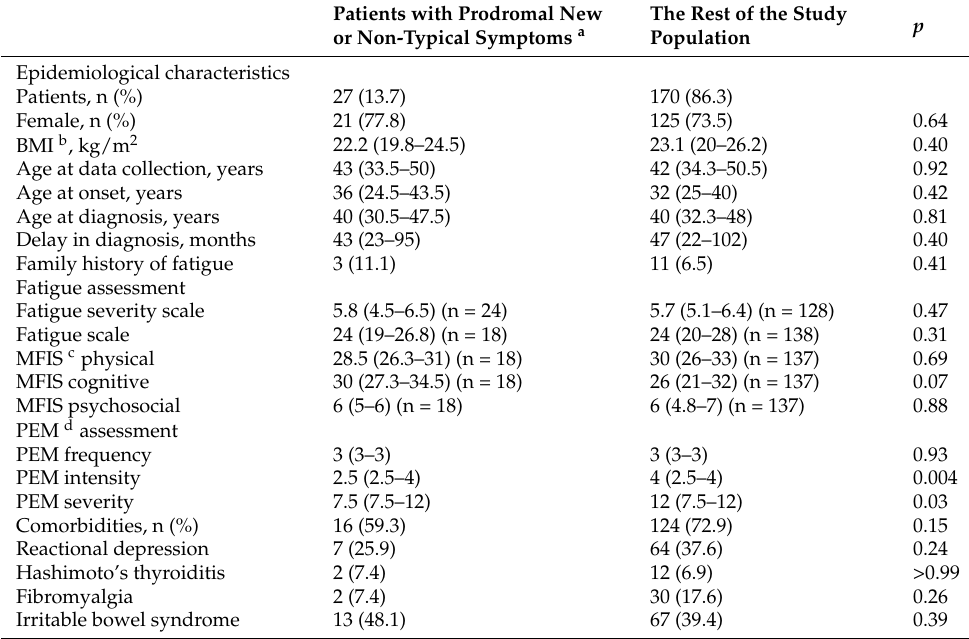
Table 1. Comparison between ME/CFS patients with prodromal new or non-typical symptoms a and the rest of the study population. The Rest of the Study Population Patients with Prodromal New or Non-Typical Symptoms a